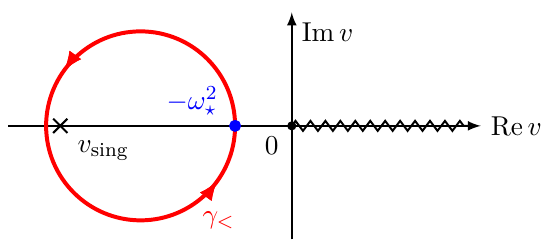
Figure 3 . The integration contour for the steepest-descent approximation of (7.19) in the α → 0 limit. The contour crosses the saddle point − ω 2 parallel to the imaginary axis. Notice that, when ? approaching v sing from the left, Re χ → + ∞